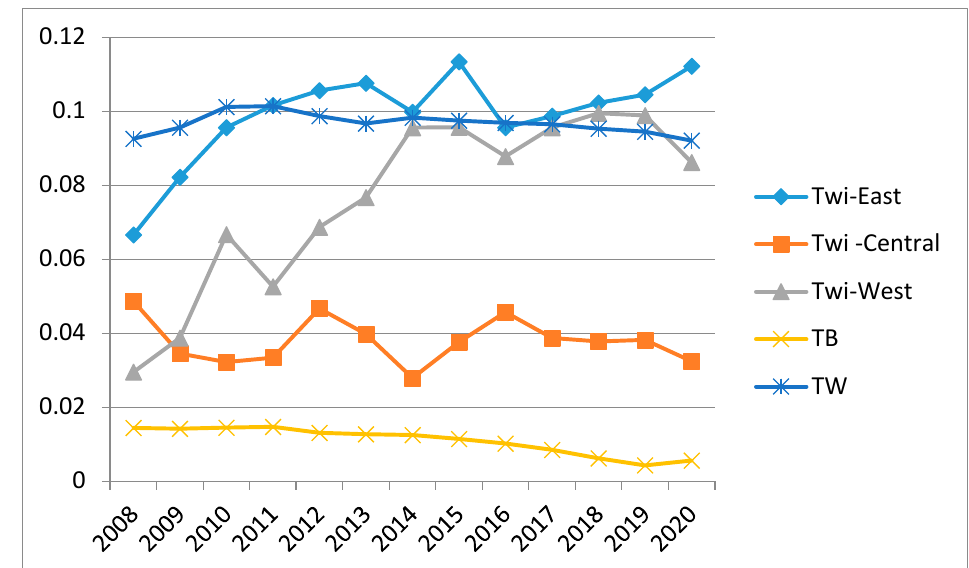
Figure 3. Trend of Theil index of transportation CEE in three regions in China.